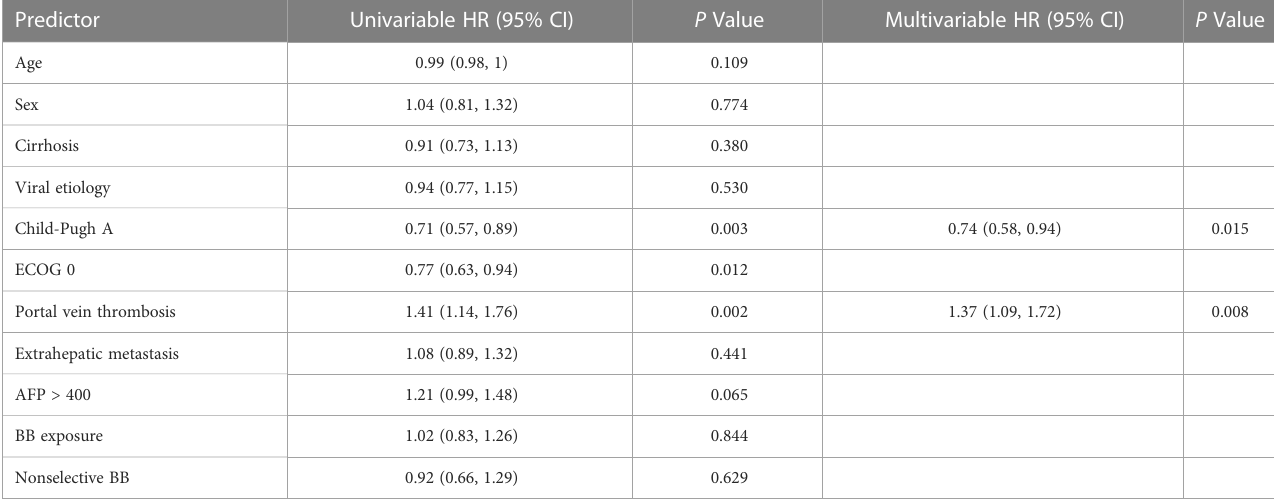
TABLE 4 Univariable and multivariable Cox proportional hazard models for progression-free survival. Predictor